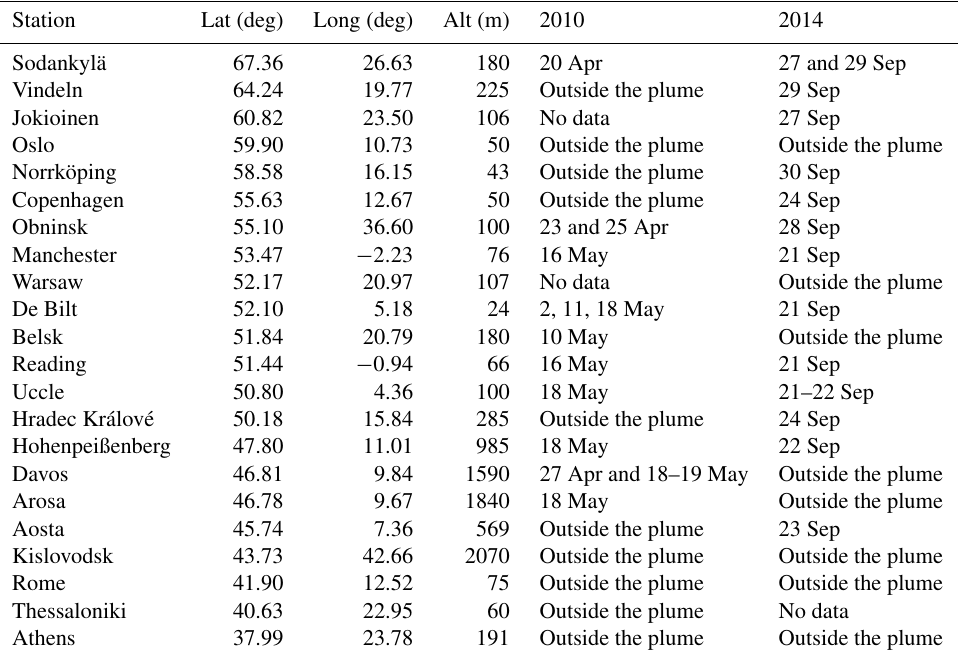
Table A1. Dates at which the Brewers were determined to be under or outside of the volcanic SO 2 plume, based on analysis of back trajectories of the volcanic plumes in 2010 and 2014. The distinction between stations outside of the plume and stations under the plume was done as follows: at each station measuring SO 2 exceeding 2DU (2 σ ), we calculated back trajectories and found that their origin was at the volcanic eruption. All these stations have been considered to be under the SO 2 plume. All other stations, for which columnar SO 2 amounts were within 2 σ and did not originate from the area of the eruption, were considered to be outside of the volcanic SO 2 plume. During the Kasatochi eruption all Brewers were considered to be under the volcanic SO 2